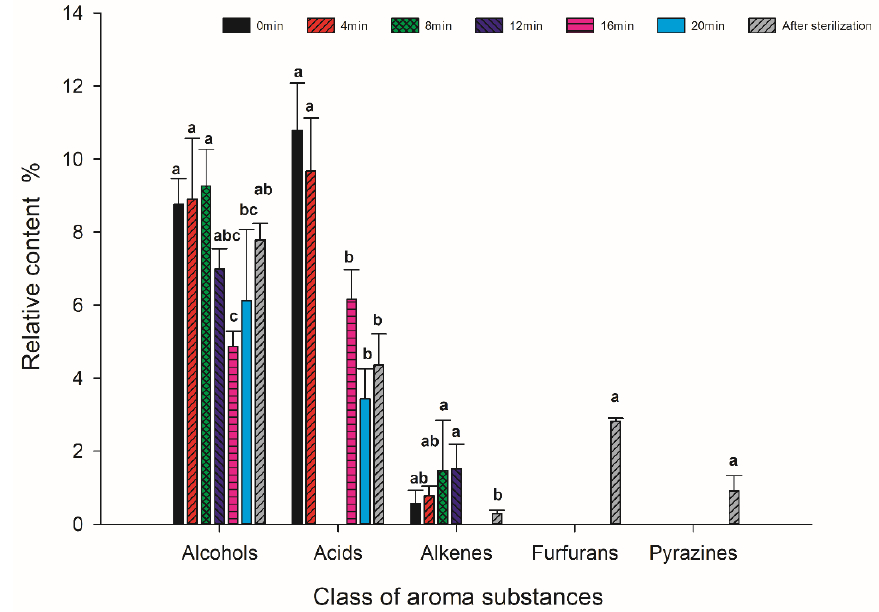
Figure 3. Relative contents of aldehydes, acids, alkenes, furfurans and pyrazines for the coconut jam obtained by GC−MS. Values identified with different letters represent significant differences for each class of compound.